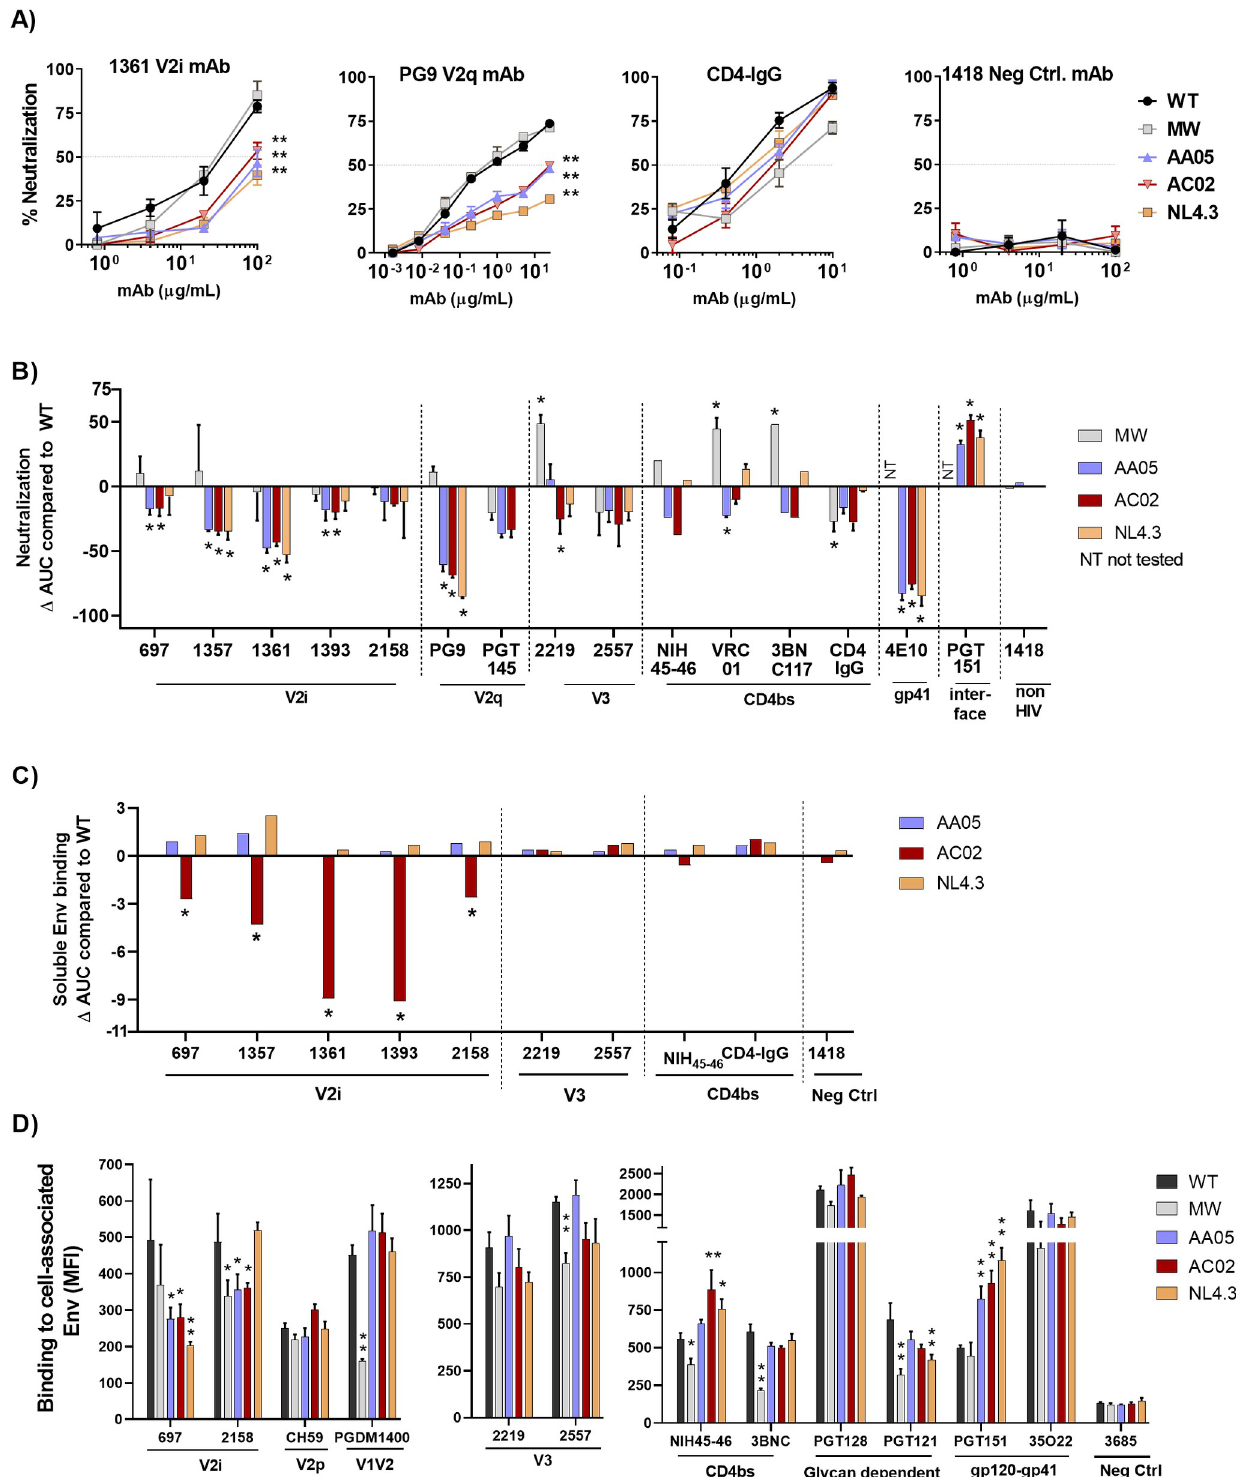
Fig 6. Effects of SP swap on REJO Env-antibody interaction. (A) Neutralization of WT and SP-swapped REJO treated with titrated amounts of anti Env mAbs. Neutralization was performed as in Fig 4A and 4B. Representative titration curves for V2i mAb 1361, V2q mAb PG9, CD4IgG and negative control mAb 1418 are shown. �� , p < 0.001 vs WT by 2-way ANOVA. (B) Changes in neutralization AUCs of WT vs SP-swapped viruses by different mAbs.